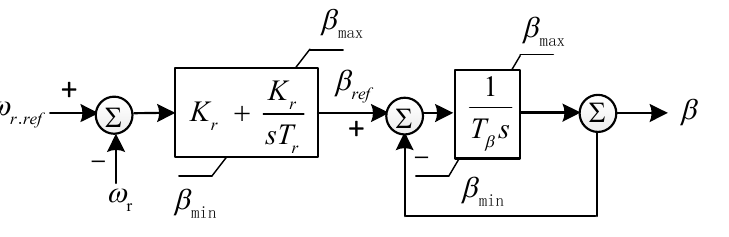
Figure 2. Pitch angle controller.